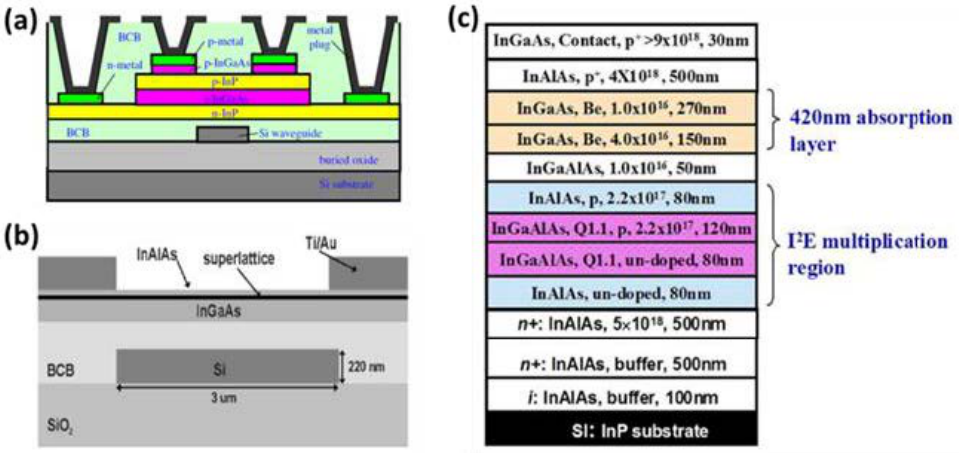
Figure 2: (a) The cross-section of an InGaAs p − i − n photodetector integrated with an SOI waveguide. (b) The cross-section of a waveguide integrated InGaAs MSM photodetector. (c) Schematic cross-section of InP/InGaAsP/InGaAs SACM APD with double-diffused floating guard